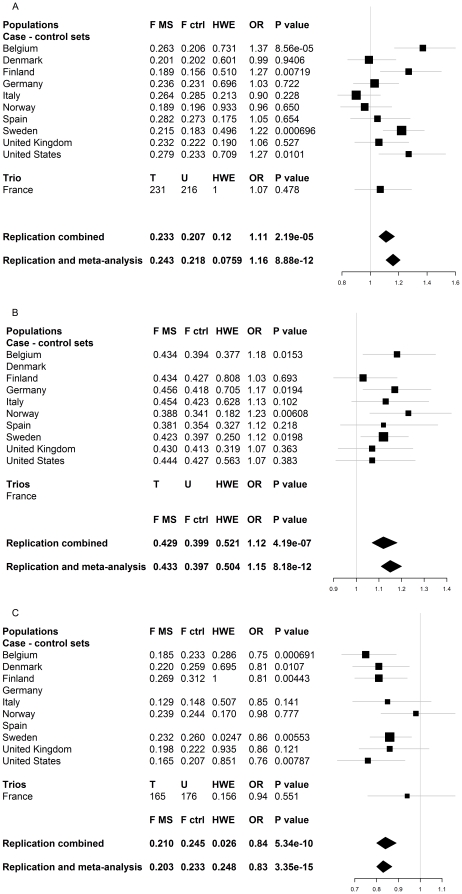
Summary of results.The results for individual populations are presented here each population on its own line. For each population we report the allele frequency in MS patients (F MS) and controls (F ctrl), Hardy-Weinberg (dis)equilibrium (HWE) p value, odds ratio (OR) and association p value. The association analyses were performed according to Kazeem and Farral [15]. The reported HWE p value is reported for cases and controls combined, but no significant deviation was observed within cases or controls when analyzed separately (data not shown). Figure 1a represents the results for rs17824933 in CD6. The Replication -line is the combined result of all independent sample sets in the replication (8,047 cases, 9,174 controls, 604 case-parent trios) and “Combined with De Jager et al. GWA” set includes the De Jager et al. [11] GWA data set (2,624 cases, 7,220 controls). Figure 1b summaries the results for rs1800693 in TNFRSF1A. Genotyping was unsuccessful in two sample sets (Danish case – control set and French case-parent trios) for rs1800693. Indipendent replication data set (“Replication”) included total of 7,665 cases and 8,051 controls and the “Combined with De Jager et al. GWA” set includes available genotypes from De Jager et al. [11] (1,829 cases, 2,591 controls). Figure 1c is a summary of results for rs17445836 (61.5 kb from IRF8). The genotyping was unsuccessful in two sample sets (Spanish and German case – control sets). The independent replication set (Replication) includes in total 6,895 cases, 7,580 controls and 596 case-parent trios and the “Combined with De Jager et al. GWA” set includes available genotypes from De Jager et al. [11] (2,624 cases, 7,220 controls).